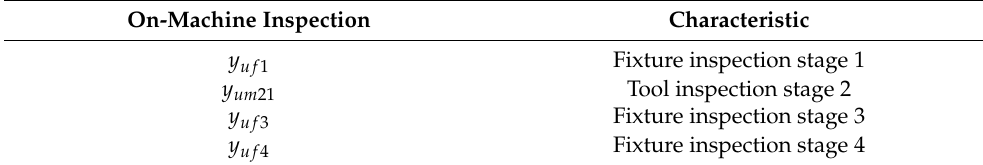
Table 3. Possible on-machine